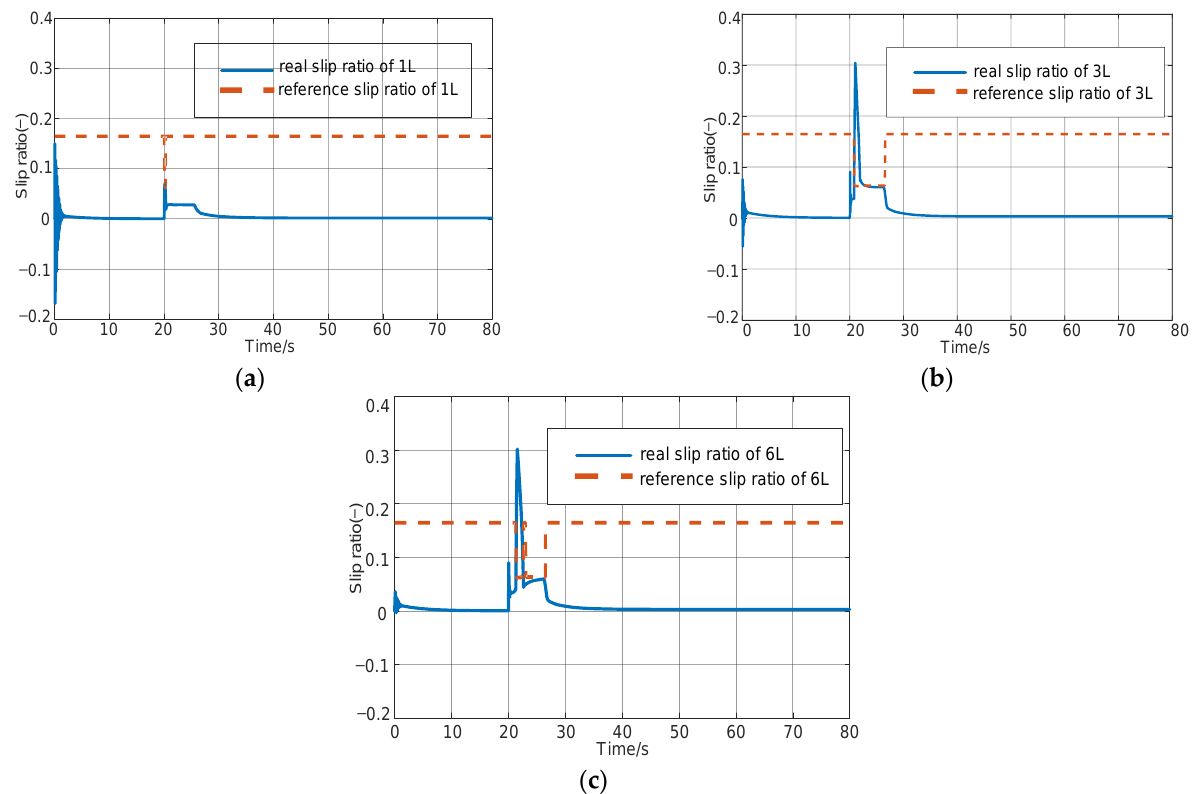
Figure 8. Slip ratio controlled by the SMC method on the changed road surface: ( a ) left wheel of the 1st axle (1L); ( b ) left wheel of the 3rd axle (3L); ( c ) left wheel of the 6th axle (6L).